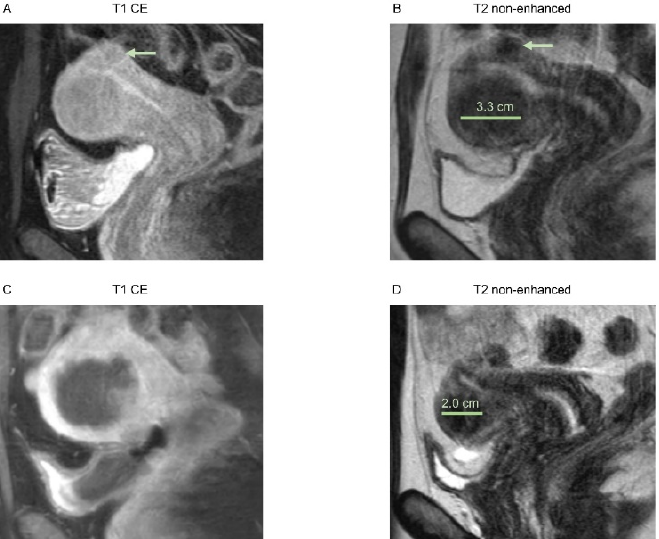
Figure 2. Images of a 39-year-old patient with multiple uterine fibroids in the anterior wall and posterior wall, Funaki grade 2. ( A ) Contrast-enhanced T1-weighted and ( B ) T2-weighted images 3 weeks before HIFU treatment of the fibroid in the anterior wall, sagittal reformation. Pre-interventional maximum diameter was 3.3 cm. A smaller subserous fibroid is depicted in the posterior wall (ar- row), which could not be reached by HIFU due to bowel loops in the beam path. ( C ) Immediate post-interventional T1 contrast-enhanced image with a volumetric assessed NPV of 64%, sagittal reformation. ( D ) T2-weighted image 6 months after intervention with a maximum diameter of 2.0 cm, sagittal